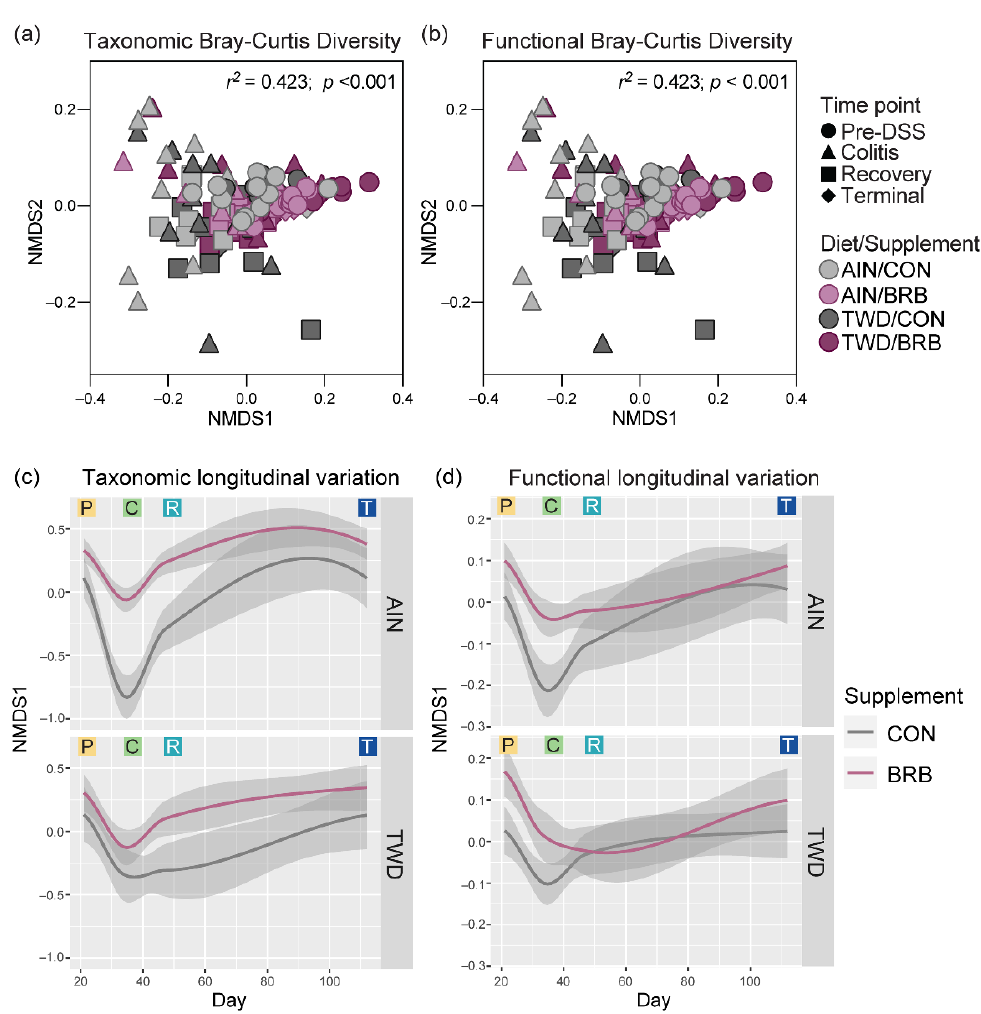
Figure 14. Longitudinal analysis of fecal microbiome taxonomy and functional capacity (experiment B). ( a , b ) NMDS ordination plots of the taxonomic ( a ) and functional ( b ) β -diversity for fecal microbiomes of mice fed either CON or BRB-supplemented diet with either AIN or TWD basal diets for all experimental time points. Functional beta diversity was measured as the Bray–Curtis dissimilarity based on KEGG term abundances, while taxonomic beta-diversity values represent the Bray– Curtis dissimilarity based on ASV abundances. ( c , d ) Longitudinal variation shown as the first dimension plotted over experimental day for taxonomic ( c ) and functional ( d ) diversity. Loess-smoothed trajectories of microbiomes from each experimental group are plotted; gray shading represents the 95% confidence interval. P, pre-DSS; C, colitis; R, recovery; and T, terminal time points.